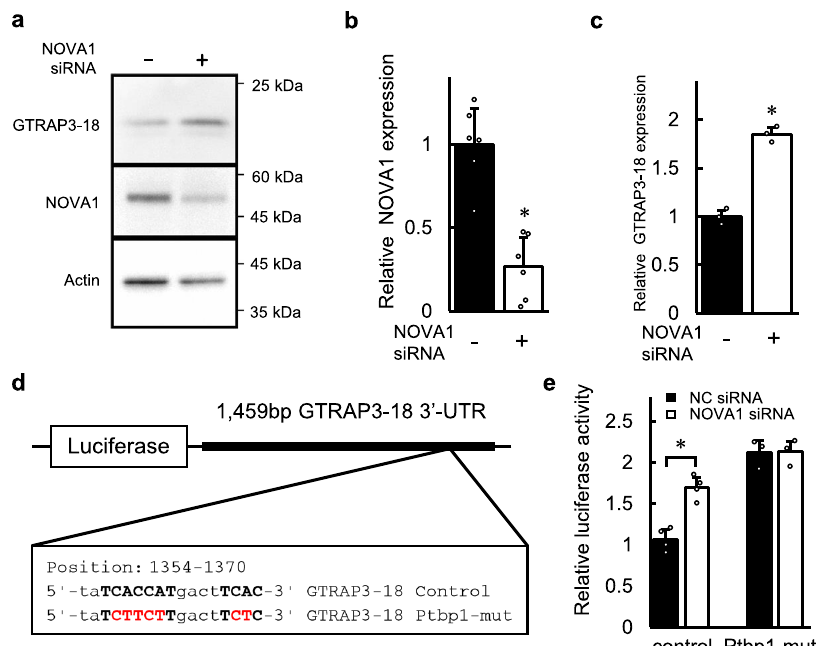
Fig. 4 The effect of NOVA1 knockdown on the expression of GTRAP3-18. a The endogenous expressions of GTRAP3-18, NOVA1 and β -actin after transfection of NOVA1 siRNA ( + ) or negative control siRNA ( − ) are shown. Molecular weight markers are depicted at right. Full blots are presented in Supplementary Fig. 15. b Densitometric quanti fi cation of the NOVA1 expression in a is shown. Data represent mean values ± SD obtained from six individual experiments and individual data points are plotted. Data were analyzed Student ’ s t -test, two-sided. * p < 0.05 relative to the negative control. c Densitometric quanti fi cation of the GTRAP3-18 expression in a is shown. Data represent mean values ± SD obtained from three individual experiments and individual data points are plotted. Data were analyzed by Student ’ s t -test, two-sided. * p < 0.05 relative to the negative control. d A schematic plot of the luciferase constructs of GTRAP3-18 3 ′ -UTR is shown. The sequence for the predicted NOVA1-binding site is shown in the box. Mutation was added in a core sequence (red font) of tandem YCAY clusters (bold font). The mutated sequence contains a predicted binding site of Ptbp1 (Ptbp1-mut). e Relative luciferase activities in SH-SY5Y cells transfected with the luciferase plasmids in d with the NOVA1 siRNA or negative control (NC) are shown. Data represent mean values ± SD obtained from independent samples ( n = 4 for control, n = 3 for Ptbp1-mut) and individual data points are plotted. Data were analyzed by Student ’ s t -test, two-sided. * p < 0.05 relative to the negative